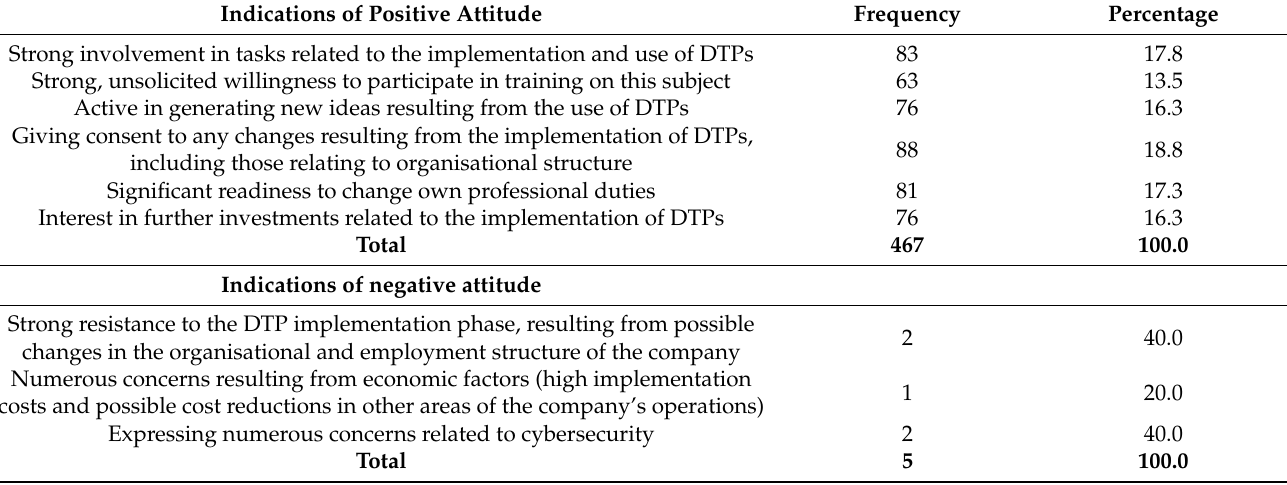
Table 3. Indications of positive and negative attitudes towards DTPs expressed by the management staff of surveyed companies.